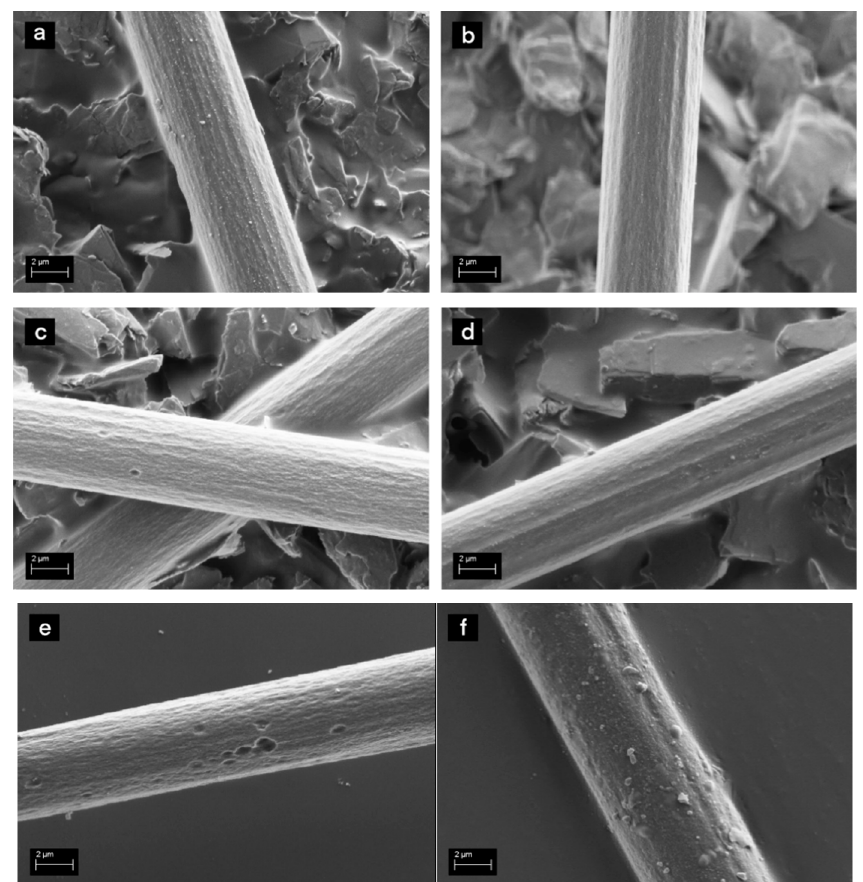
Figure 5. SEM images of rCF: ( a ) rCF without surface treatments, ( b ) rCF after acetone washing, and ( c ) rCF after acidic pre-treatment, ( d ) of resized rCF in PP film former with 1 w-% solution, ( e ) 1 w-% solution on acid treated rCF and ( f ) 5 w-% solution.